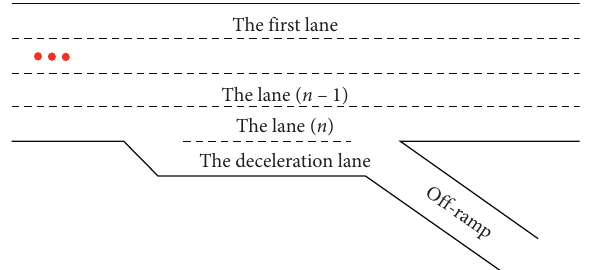
Figure 1: Typical off-ramp area